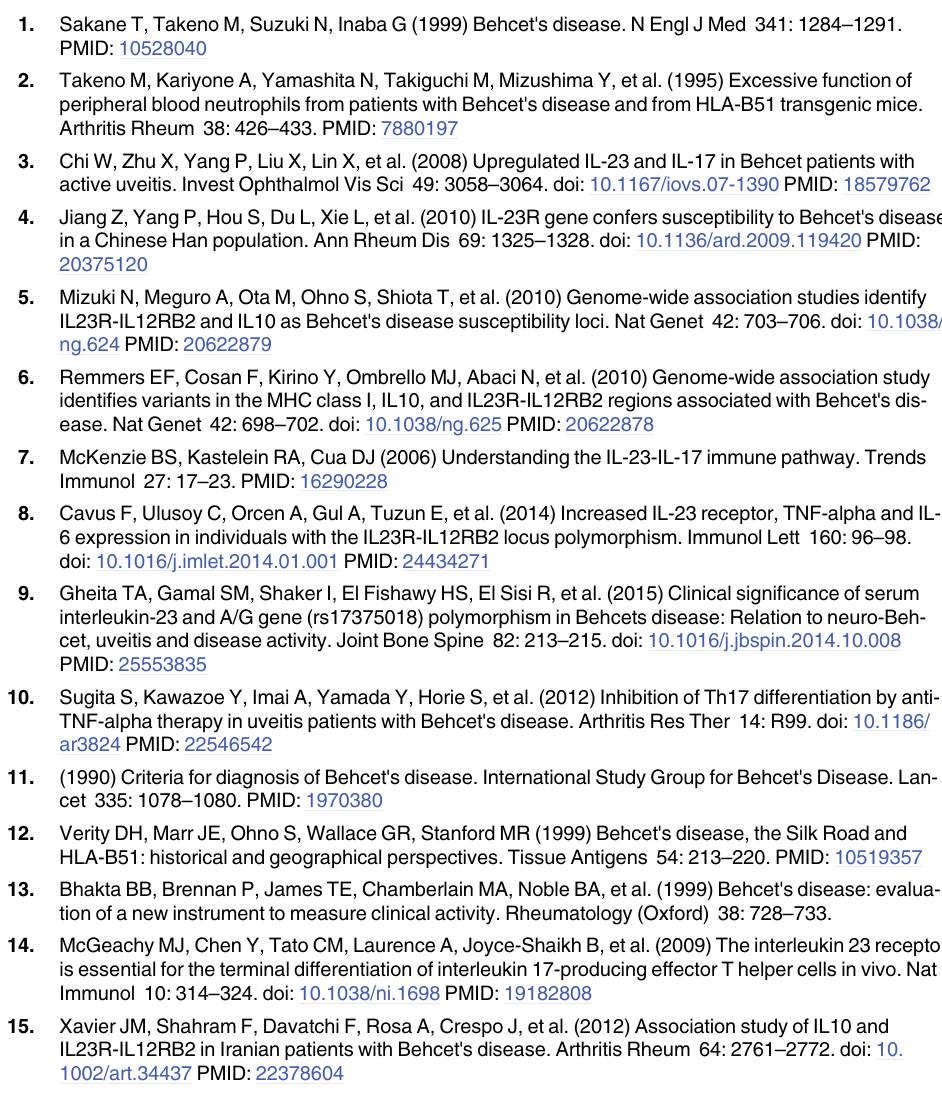
S5 Table. The data of the expression about TNF- α in BD patients and healthy controls.